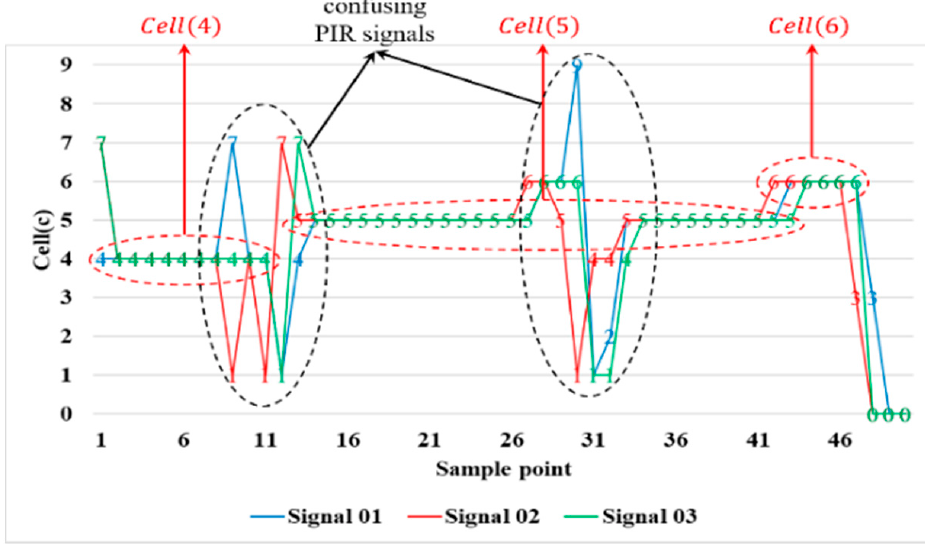
Figure 3. Feature PIR signals: moving from Cell(4) to Cell(6).